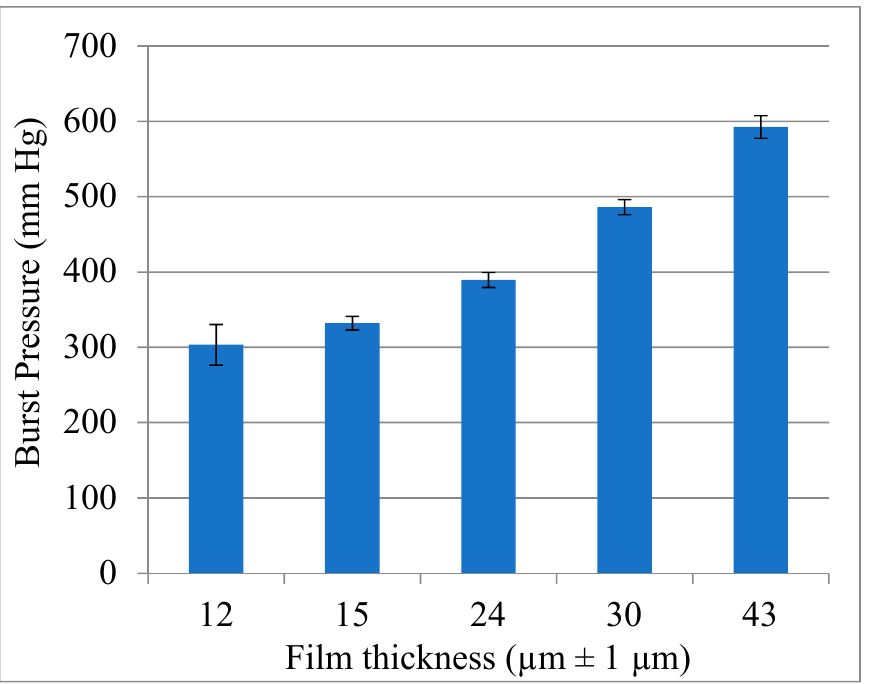
Figure 6. Preparation of the sleeve. Burst pressure of thin CLUR film (error bars are SD, n = 5). Similar to the coatings used in drug-eluting stents [39,40], the struts of the metallic stent were coated with a 10 ± 5 µ m thick layer, rendering the stent in vivo weldable to the sleeve. Since the EVAR procedure was conducted under fluoroscopic monitoring and, seeking to visualize the position of the polymer sleeve, two small radiopaque markers were placed at the ends of the sleeve using a silver paste (Figure 7a). The markers are visible at the ends of the sleeve while being deployed by the angioplasty balloon and being welded to the pre-coated stent, as shown in Figure